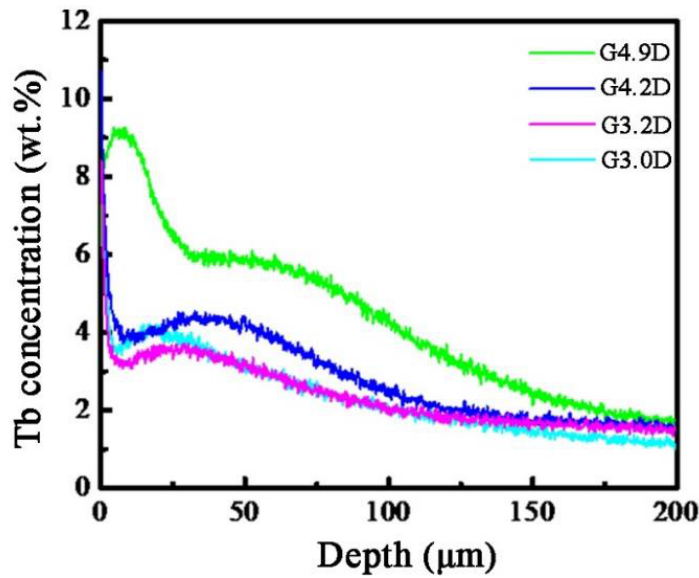
Figure 4. Tb contents as a function of depth from the surface of G4.9D, G4.2D, G3.2D, and G3.0D diffused magnets.